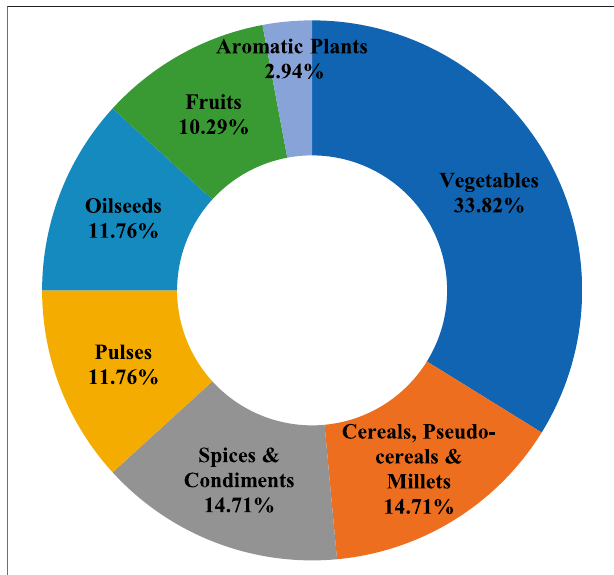
FIGURE 2 | Categories of agri-horticultural plant species used in food, nutrition, and primary health care.